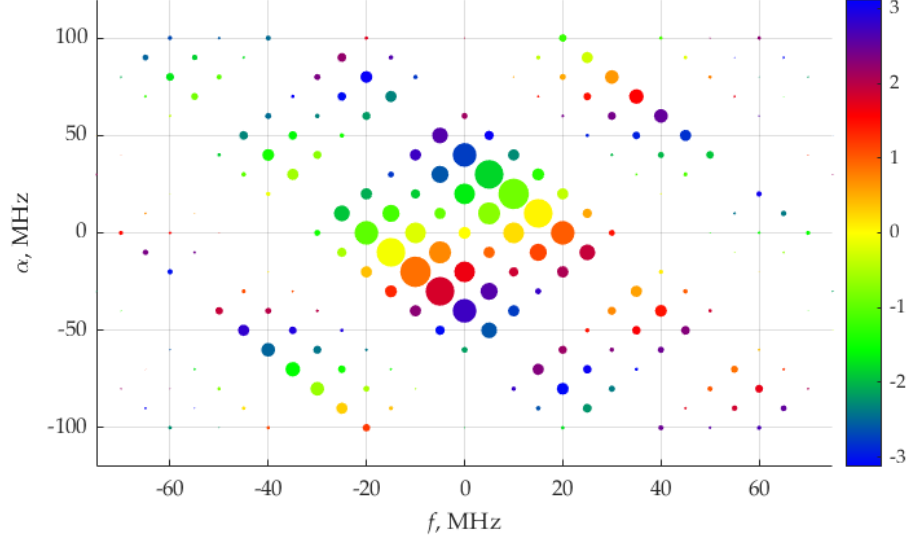
Figure 17. CSCD for the case of transmission line and pulse train current.